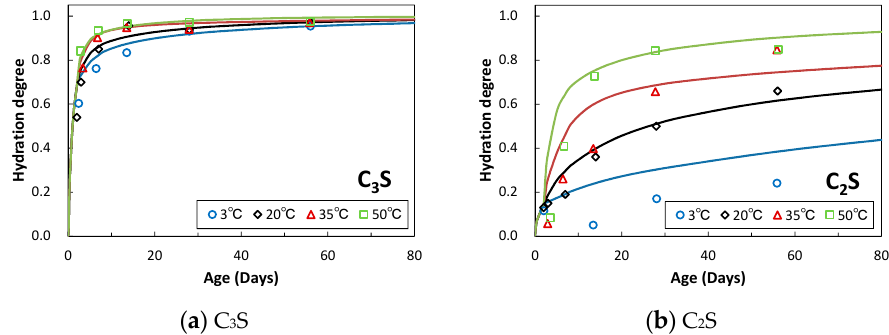
Figure 11. Comparison of degree of hydration among different curing temperatures based on the modified model (OPC, W/C = 50%) [18].